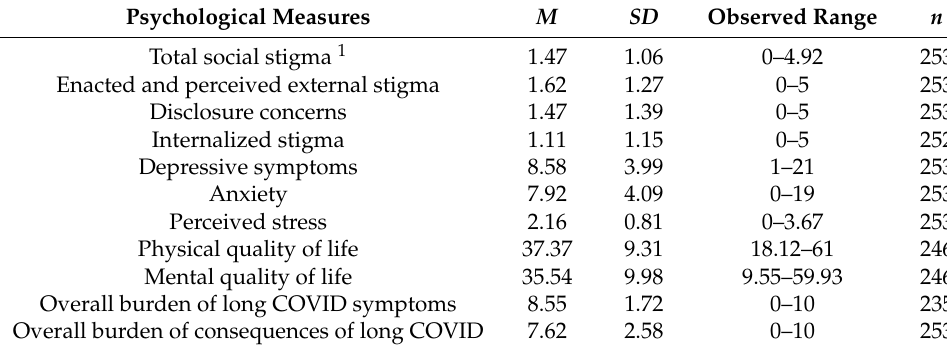
Table 1. Descriptive statistics for the main constructs of this